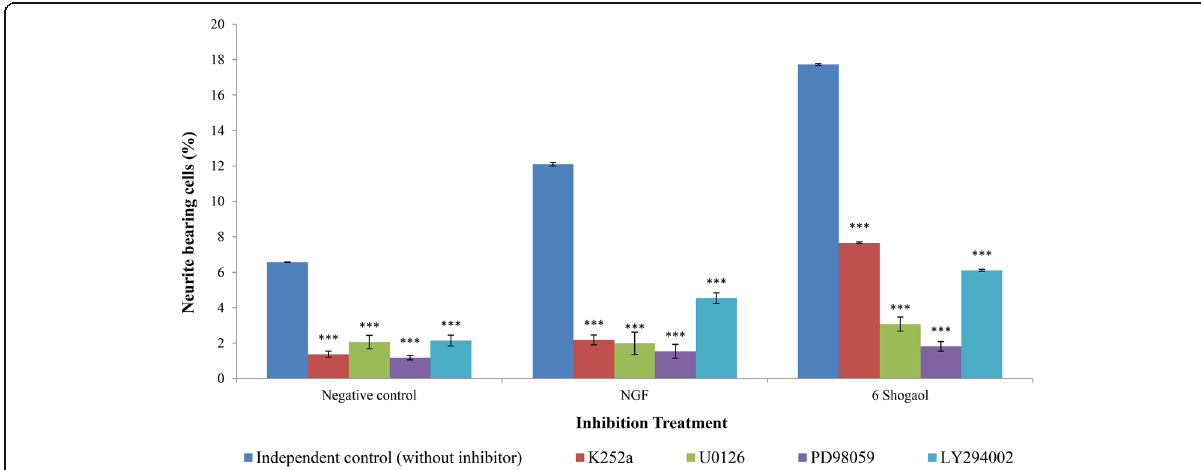
Fig. 6 Inhibition effect of the specific inhibitors on NGF-, or 6-shogaol induced neuritogenesis in PC-12 cells. Cells were pre-treated with K252a, U0126, PD98059 and LY294002 for one hour before the treatment with NGF (50 ng/ml) or 6-shogaol (500 ng/ml). Cells in complete F-12 K medium served as a negative control. An independent control (without inhibitor) was used in each treatment group. Data were expressed as means ± SD from three independent experiments carried out in triplicates. *** p < 0.001 compared to the respective